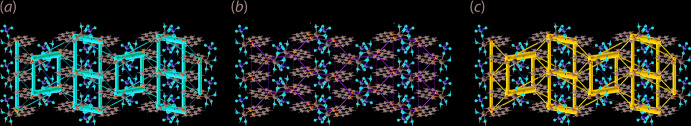
Perspective views of the energy frameworks calculated for (I), showing the (a) electrostatic potential force, (b) dispersion force and (c) total energy, each plotted down the b axis. The radii of the cylinders are proportional to the relative magnitudes of the corresponding energies and were adjusted to the same scale factor of 20 with a cut-off value of 5 kJ mol−1 within 2 × 2 × 2 unit cells.